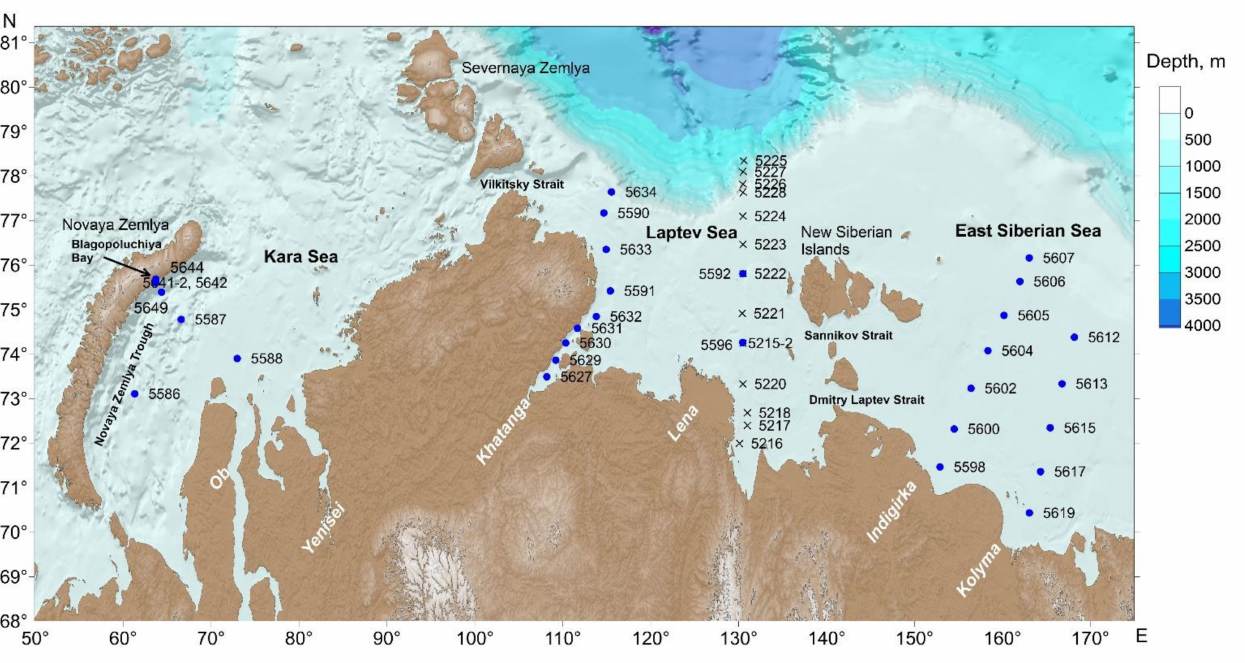
Figure 1. Sample site locations during the 63rd (black crosses) and 69th (blue dots) cruises of the R/V Akademik Mstislav Keldysh . The data from the study of Amante et al. [36] were used for the map